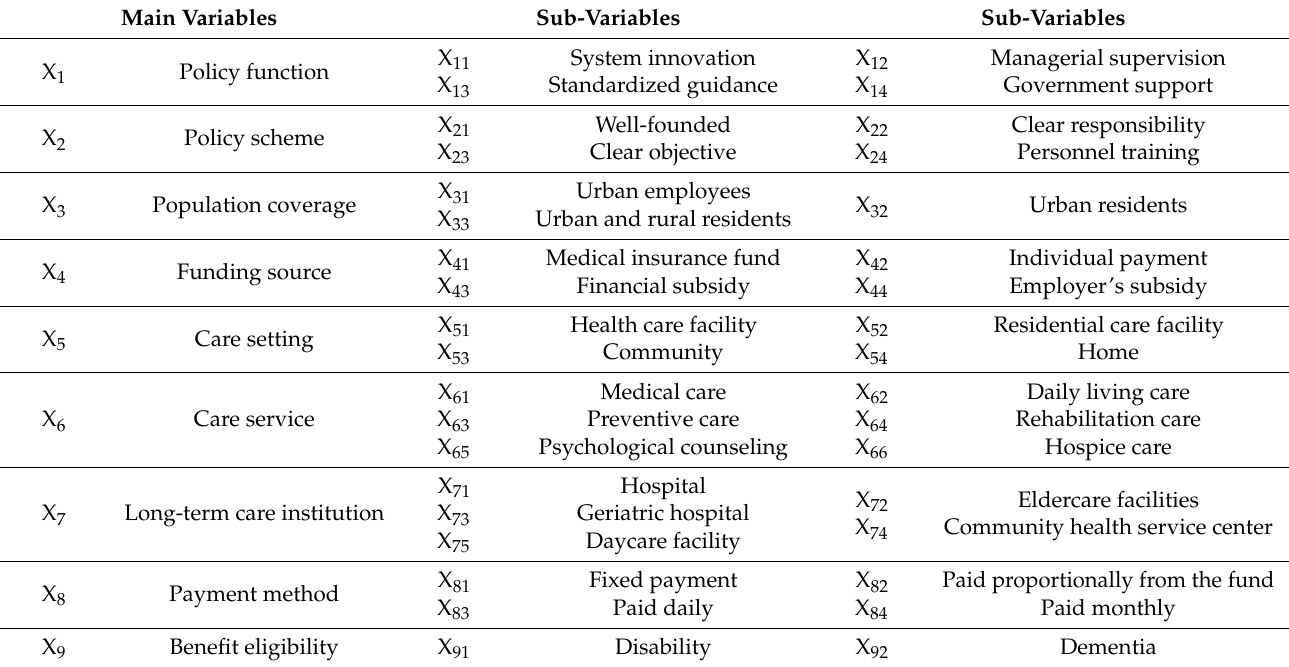
Table 1. Main and sub-variables for the PMC index